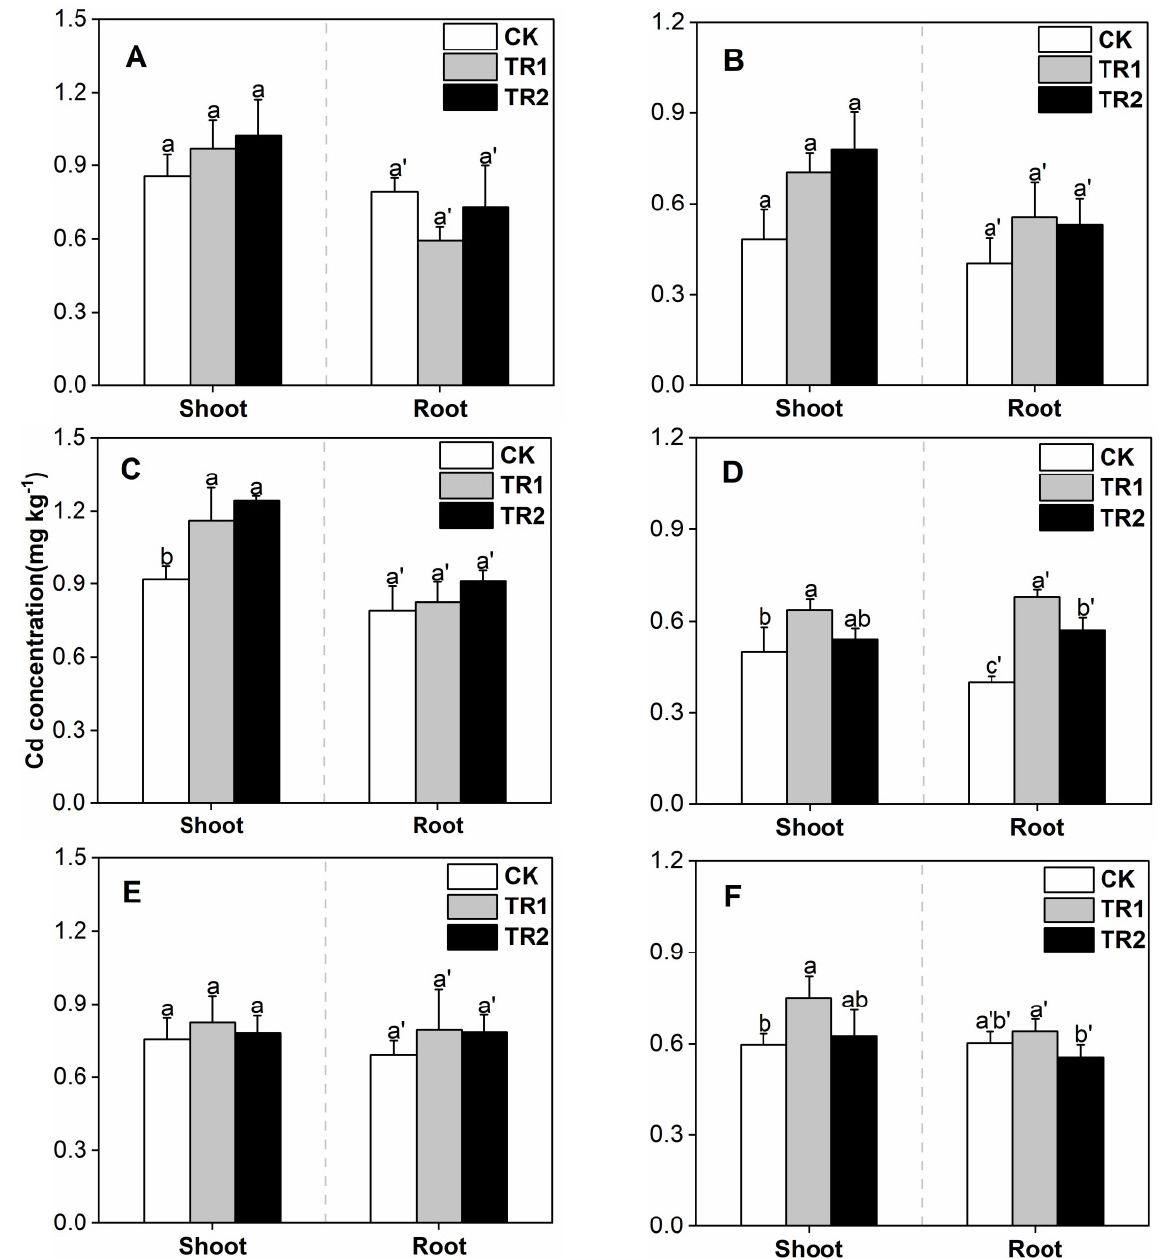
Figure 5. Oil sunflower Cd concentration. ( A ) First period intercropping papaya, ( B ) Second period intercropping papaya, ( C ) First period intercropping grapefruit, ( D ) Second period intercropping grapefruit, ( E ) First period intercropping fig, ( F ) Second period intercropping fig. The different letters above the column indicate the significant differences among different treatments at p < 0.05.